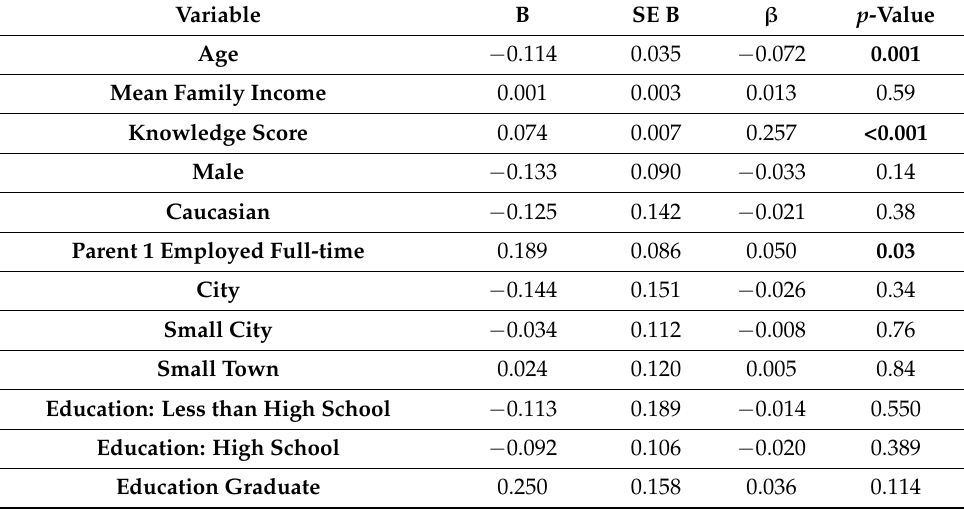
Table 4. Regression analysis of participant sociodemographic variables, total knowledge score, and total servings of fruits and vegetables (n =